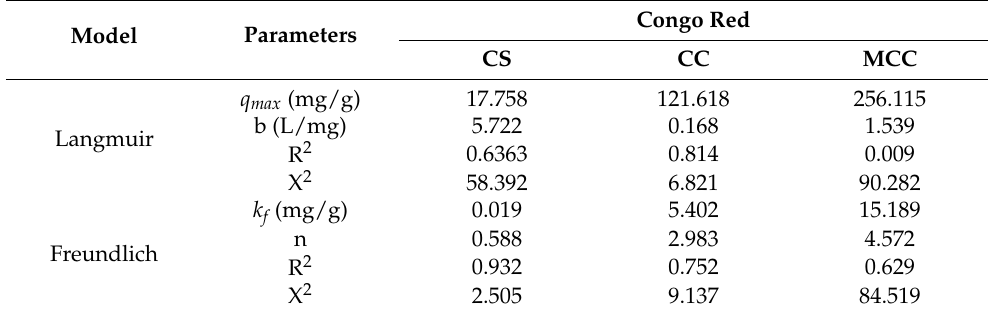
Table 5. Adsorption isotherm parameters.